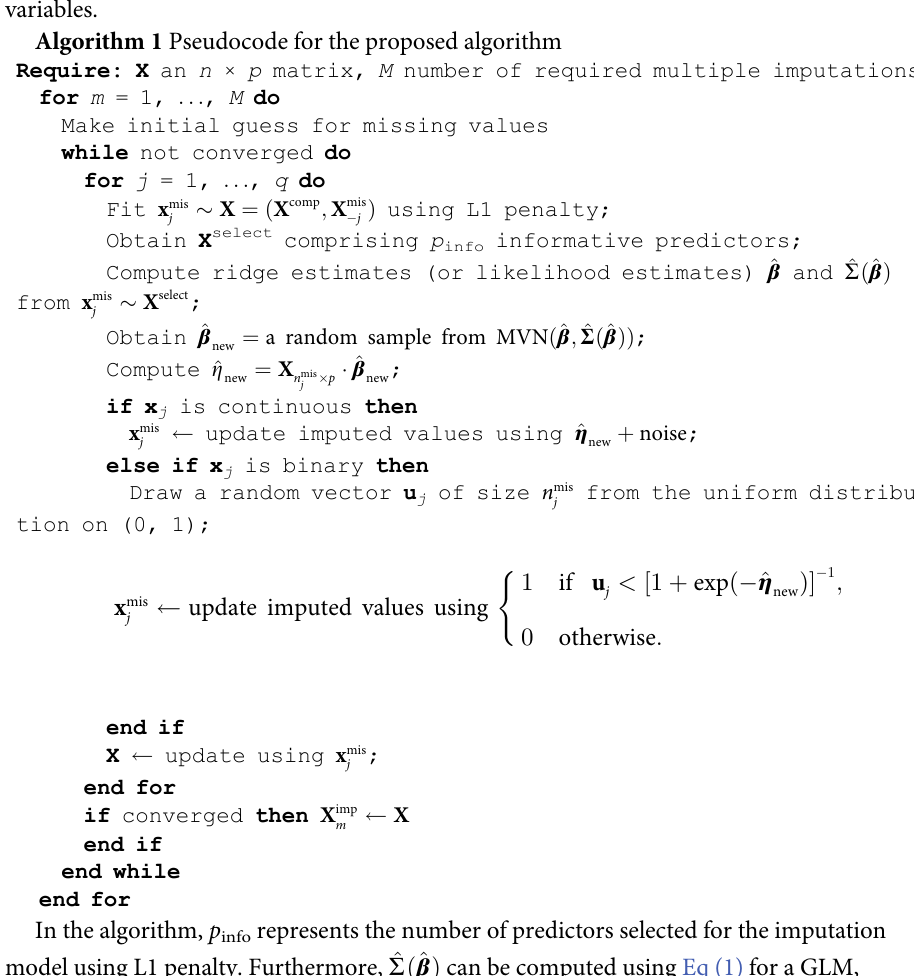
Algorithm 1 Pseudocode for the proposed